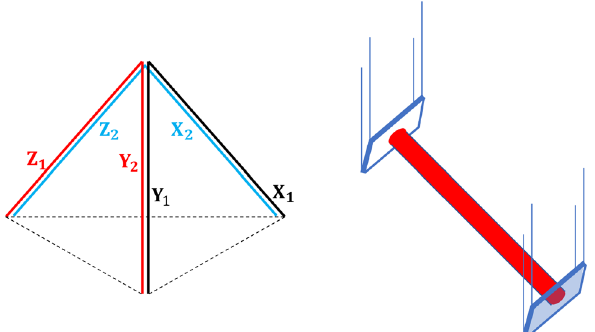
Figure 1. Sketchy configuration of the 3-D interferometer. Left panel: geometry of the three sub- interferometers in a shape of regular triangular pyramid. Right panel: configuration of one arm.